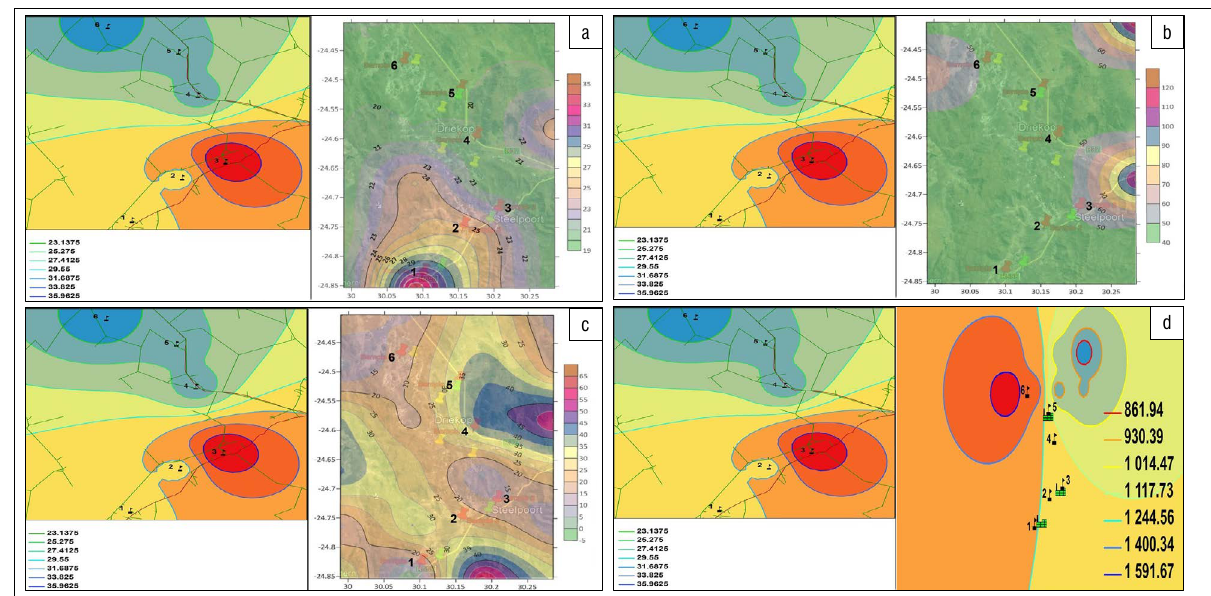
Spatial distribution of PM and (a) air pollution potential, (b) mixing height, (c) Monin–Obukhov length and (d) ventilation coefficient. 10 slope to the east of Site 3, which is an indication that mountain winds may be responsible for this flow pattern. The lowest concentrations are centred on Site 6 and extend to Site 5 and Site 4. The lowest APP values are also encountered in the same area as that of the low PM 10 concentrations which is in contrast to the APP definition. Site 1 and Site 2 have moderate PM concentrations, which could be attributed to the 10 fact that the area from Site 4 to Site 6 is within a broader mountain valley floor base, compared to the area from Site 1 to Site 3 which has a narrow mountain valley floor